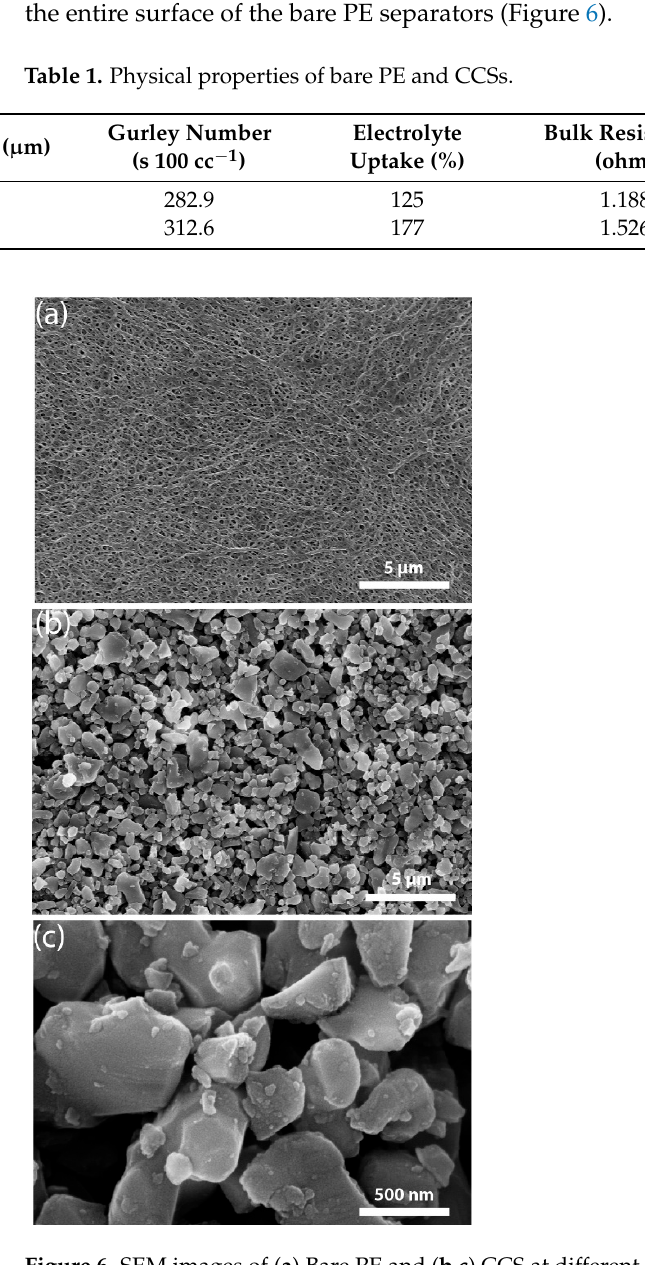
Figure 6. SEM images of ( a ) Bare PE and ( b , c ) CCS at different magnification.